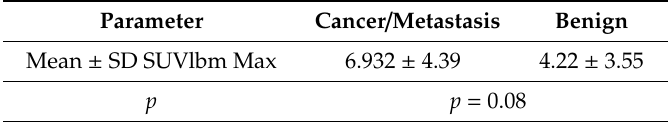
Table 1. The standardized uptake value lean body mass (SUVlbm Max) mean for benign and malignant lesions. SD—standard deviation.